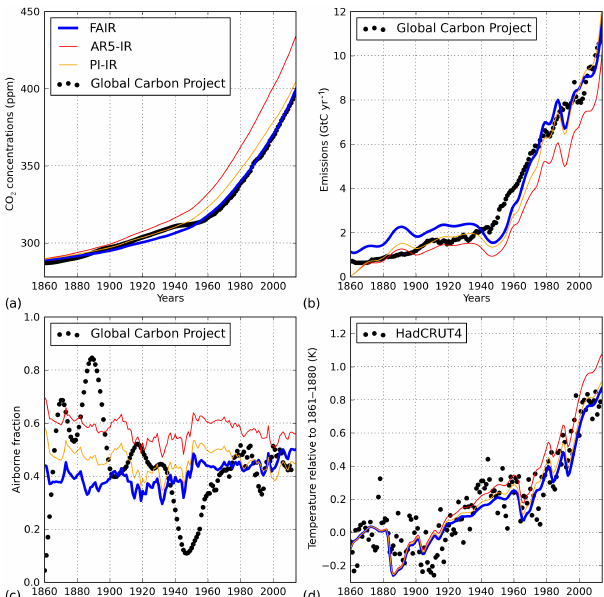
Figure 1. Historical validation of the FAIR (blue), AR5-IR (red), and PI-IR (orange) models. (a) shows simulated CO 2 concentra- tions when driven by historical emissions (and historical non-CO 2 forcing) as estimated by MAGICC. (b) shows diagnosed CO 2 emis- sions consistent with historical concentrations. (c) shows the evolu- tion of annual airborne fraction (smoothed with a 7-year running mean for the observations), and (d) the warming anomaly when driven by historical emissions. Historical observations are shown as black dots in all panels. (a, b, c) show Le Quéré et al. (2015) and HadCRUT4 (Morice et al., 2012) is shown in (d) . All simula- tions are commenced from assumed quasi-equilibrium carbon-cycle states in